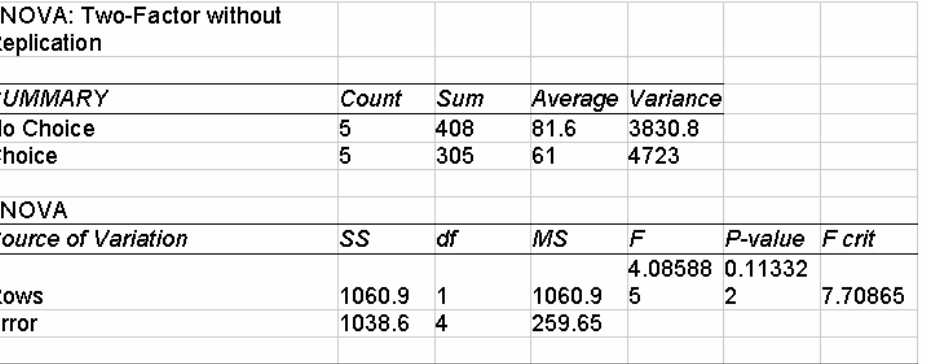
Table 2. Student satisfaction of "Choice" and "No Choice" groups